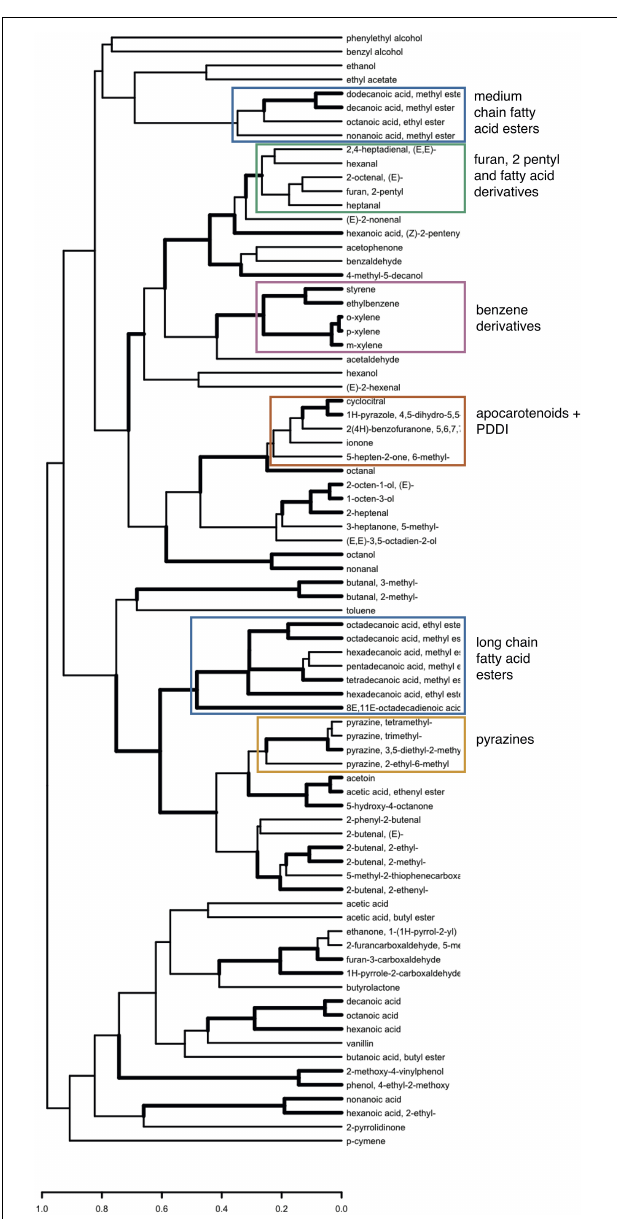
FIGURE 5 | Hierarchical clustering analysis of 80 volatiles across date palm samples based on Spearman’s rank correlation. Distances used in clustering were calculated as 1— ρ . Edges represented by heavy lines are supported by approximately unbiased P -values < 0.05 inferred from